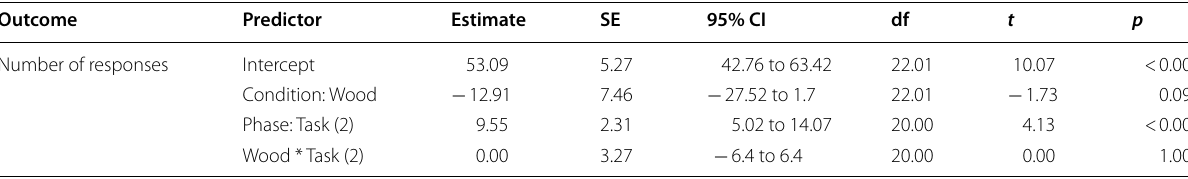
Significant predictors ( p < 0.05) are shown in